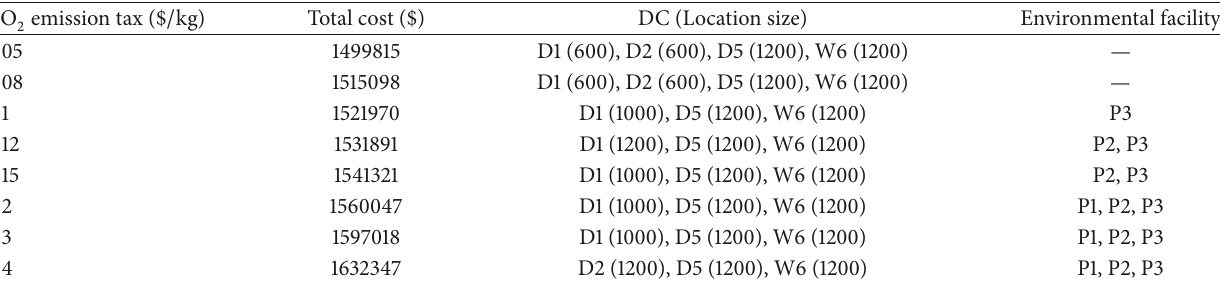
Table 9: Comparison based on different ratios of carbon tax.